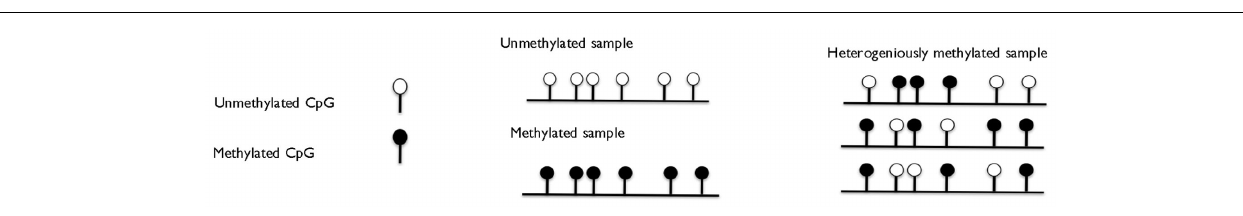
Frontiers in Genetics |